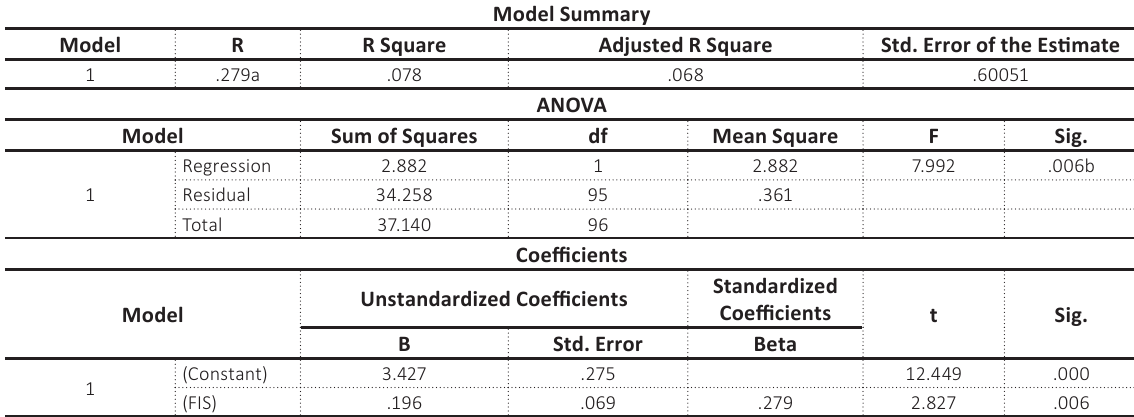
Table 6. Testing the 2nd